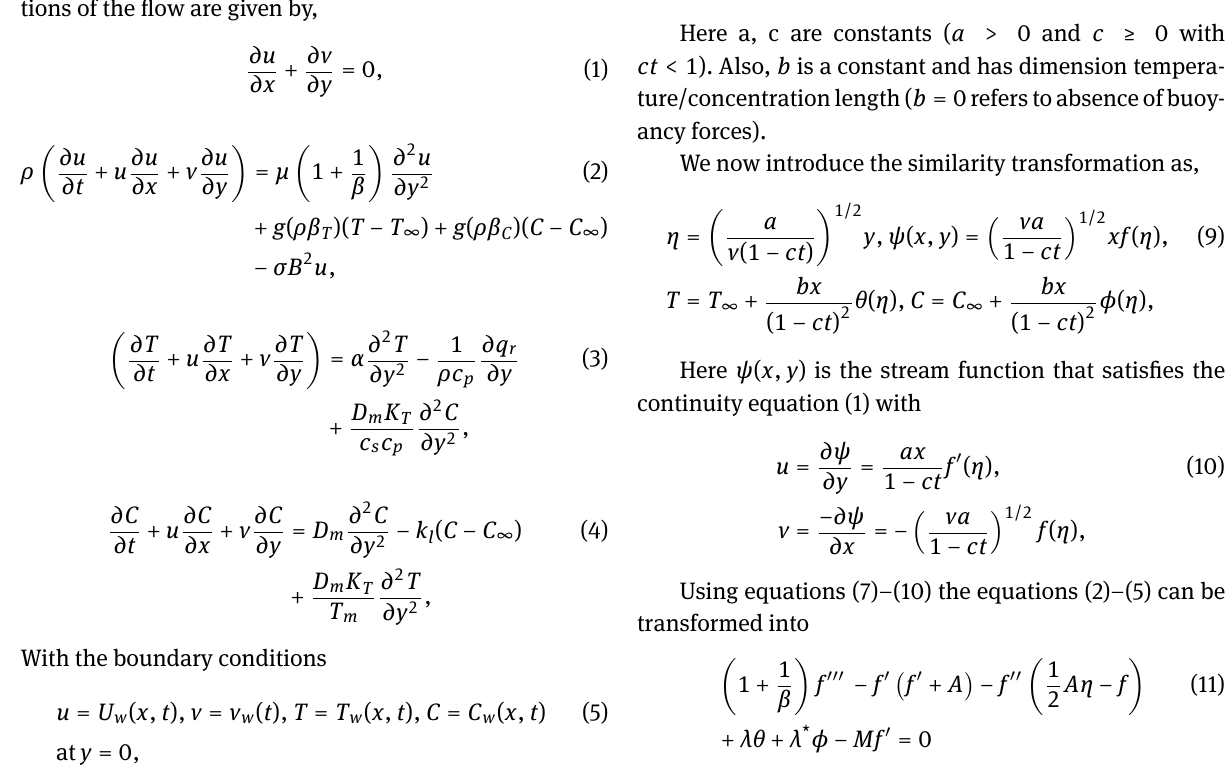
Where π = e and e is the ( i , j ) th component of the ij e ij ij deformation rate with itself, π is the critical value of this c product based on the non-Newtonian model, µ is the B plastic dynamic viscosity of the non –Newtonian fluid and p y is yield stress of the fluid. Under above made assumptions the governing equa- tions of the flow are given